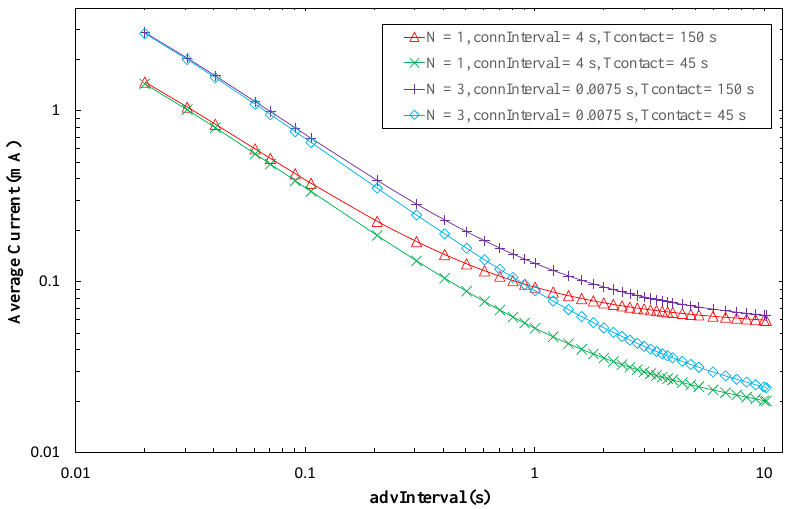
Figure 13. Average current consumption of the sensor node within a T conn period in the connection-based approach, as a function of connInterval , for several BER values, and for N = 3, advInterval = 0.02 s, and T contact = 150 s.